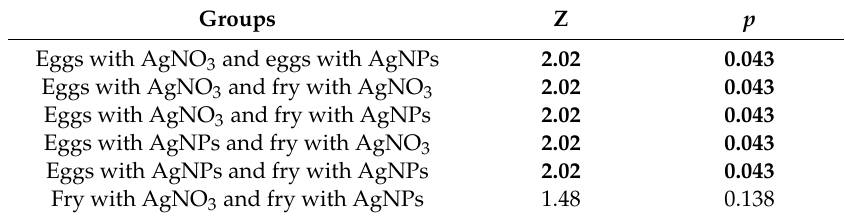
Table 2. Significant di ff erences were observed in the Ag contents in rainbow trout eggs and fry after swelling with di ff erent concentrations of AgNO 3 and AgNPs. The statistically significant correlations are marked in bold ( p <